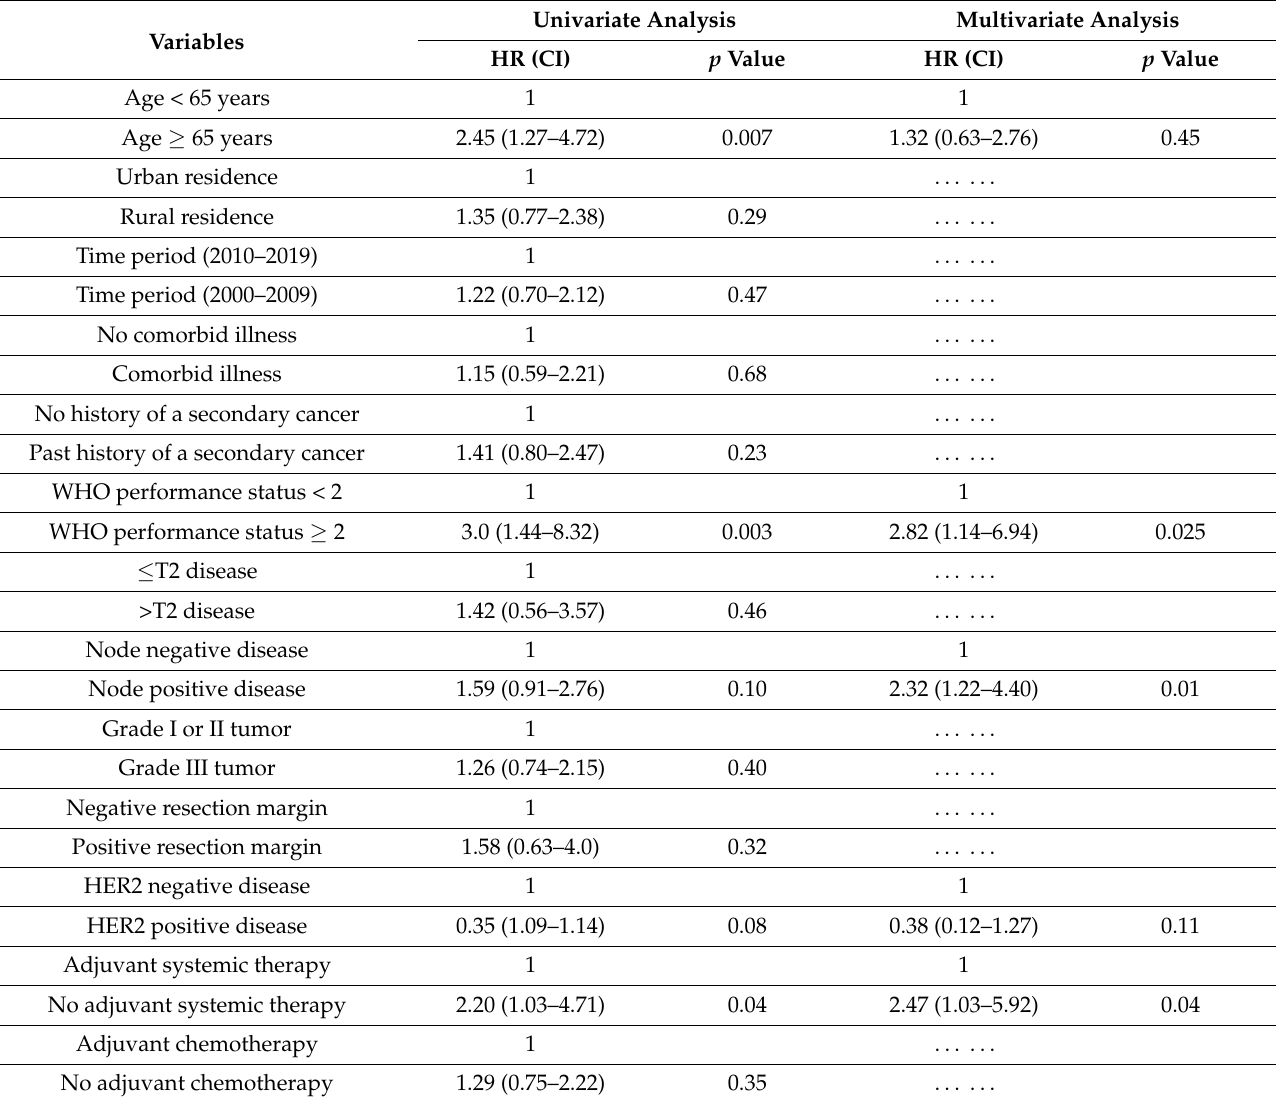
Table 3. Cox proportional analysis for disease-free survival for 91 patients with early-stage invasive breast